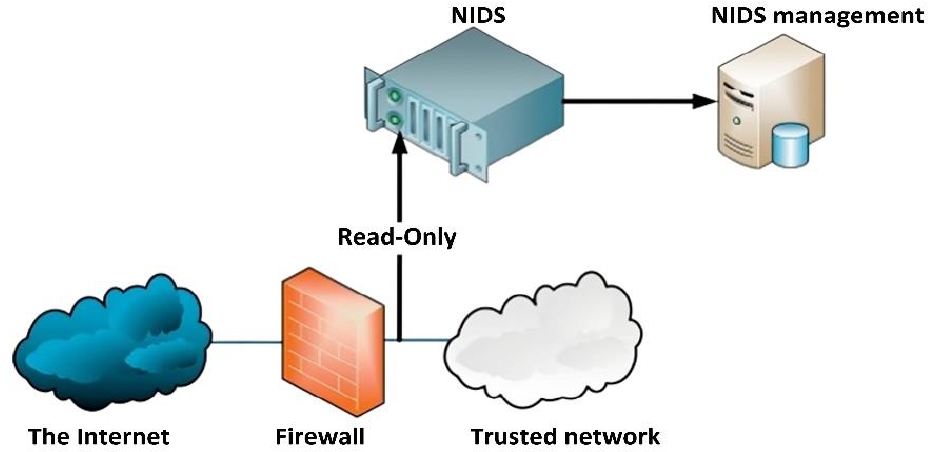
Figure 2. Typical NIDS architecture.